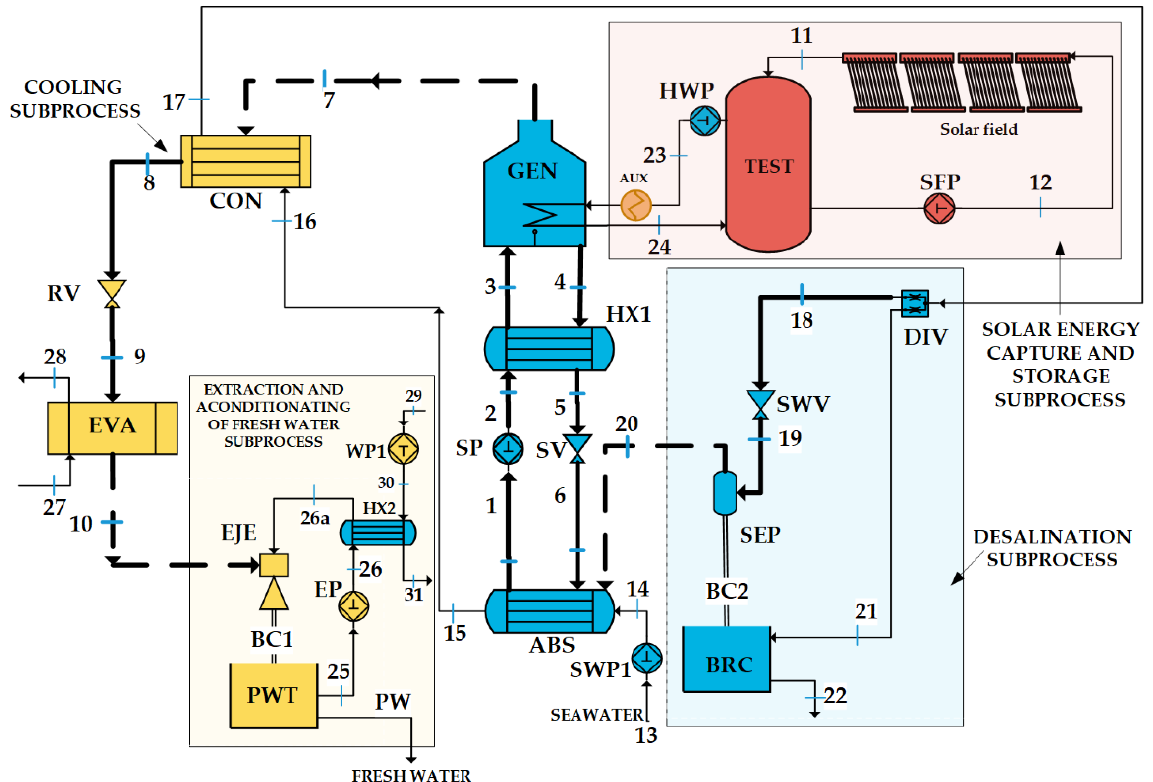
Figure 15. Schematic diagram of the solar-powered SSF/ABR hybrid system (adapted from [125]).